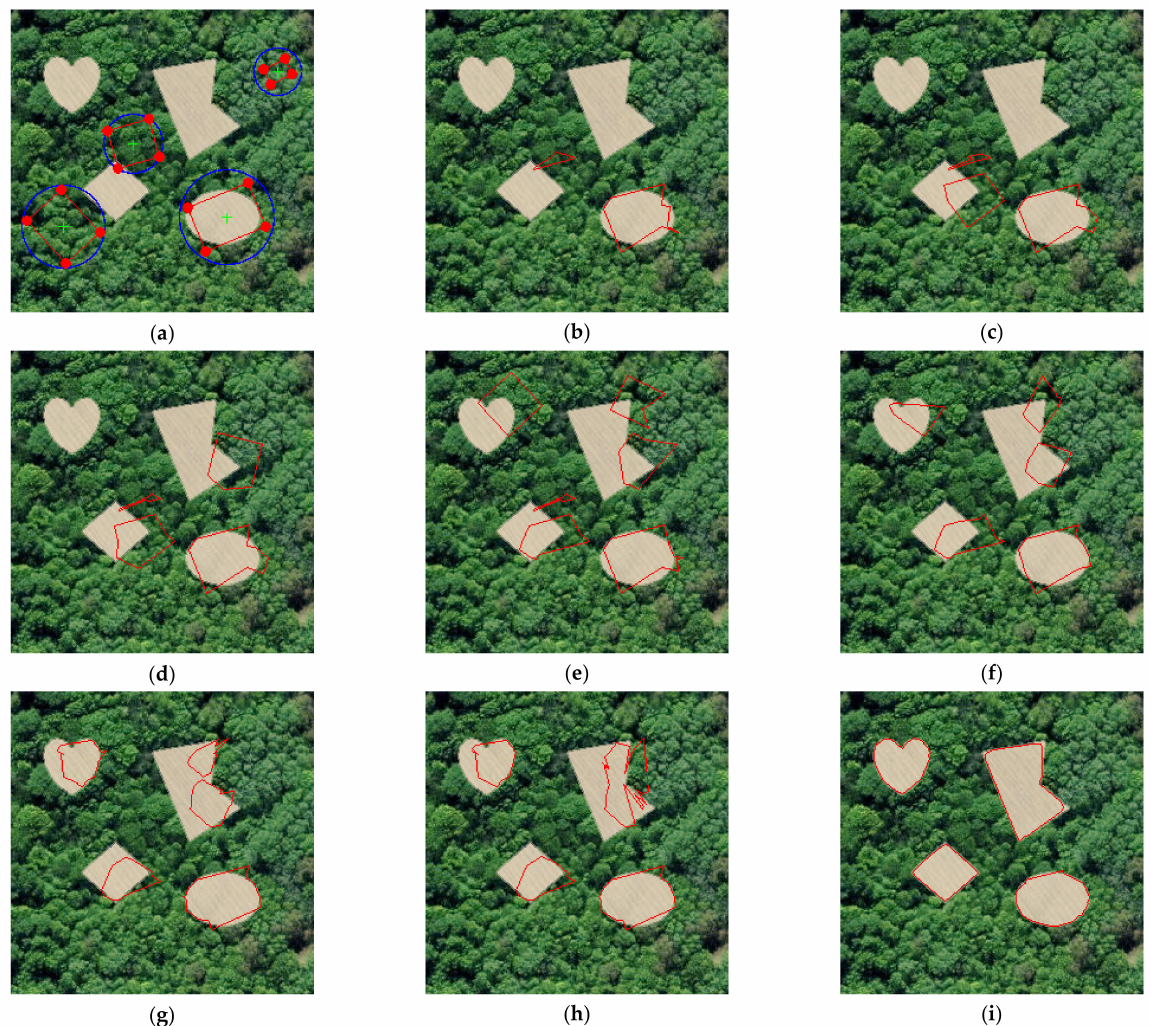
Figure 7. The process of ground object extraction from synthetic images: ( a ) Initialization; ( b ) 20th iteration; ( c ) 40th iteration; ( d ) 60th iteration; ( e ) 80th iteration; ( f ) 200th iteration; ( g ) 580th iteration; ( h ) 600th iteration; ( i ) 4000th